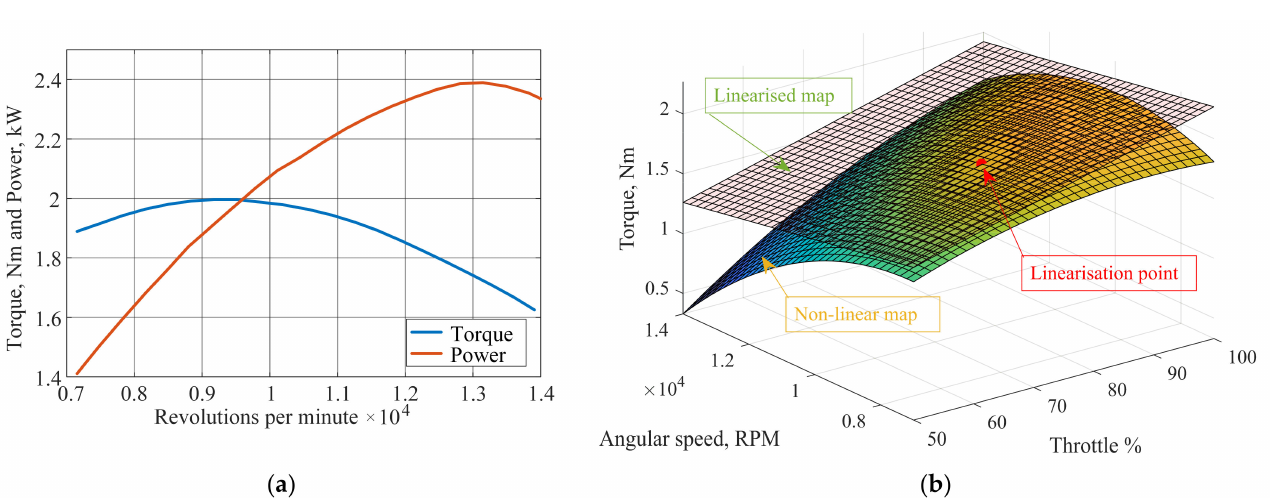
Figure 7. ICE characterization ( a ) Power and torque curves for G320RC provided by manufacturer product specifications (© Husqvarna Zenoah Co. Ltd) as shown in [20]; ( b ) torque map linearized in the vicinity of ICE operating